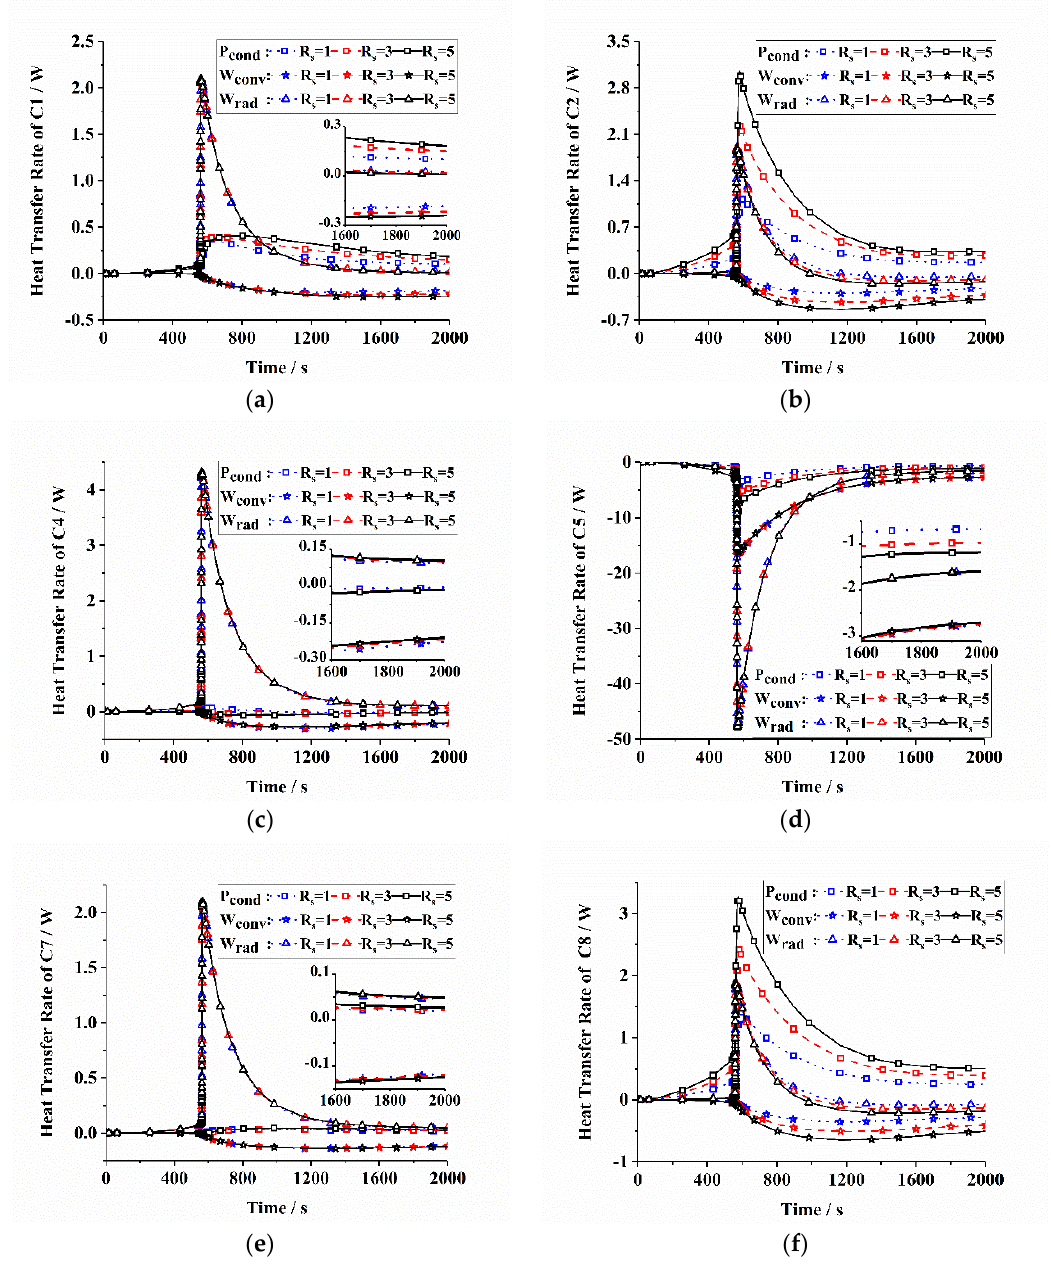
Figure 4. Heat transfer rates of different heat transfer modes of each cell when R s = 1, 3 and 5 mm (S = 4 mm, W = 10 mm); ( a ) C1, ( b ) C2, ( c ) C4, ( d ) C5, ( e ) C7, ( f ) C8.